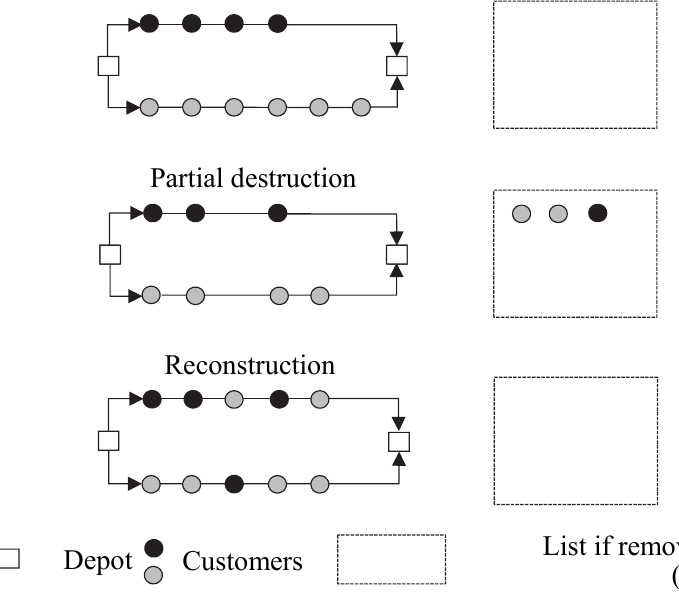
Fig. 3. Large Neighbourhood Search